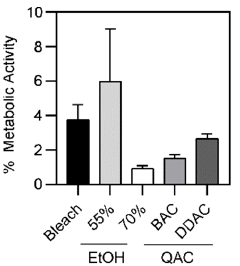
Figure 4. Bacterial biofilm survival when exposed to various microbicides. A comparison of average biofilm survival when exposed to various microbicidal agents. No significant differences were observed between all microbicides at their proper contact times (4 min for bleach, 1 min for 55% and 70% ethanol and DDAC, and 2 min for BAC). The average metabolic activity of all strains is displayed; error bars represent standard deviation.